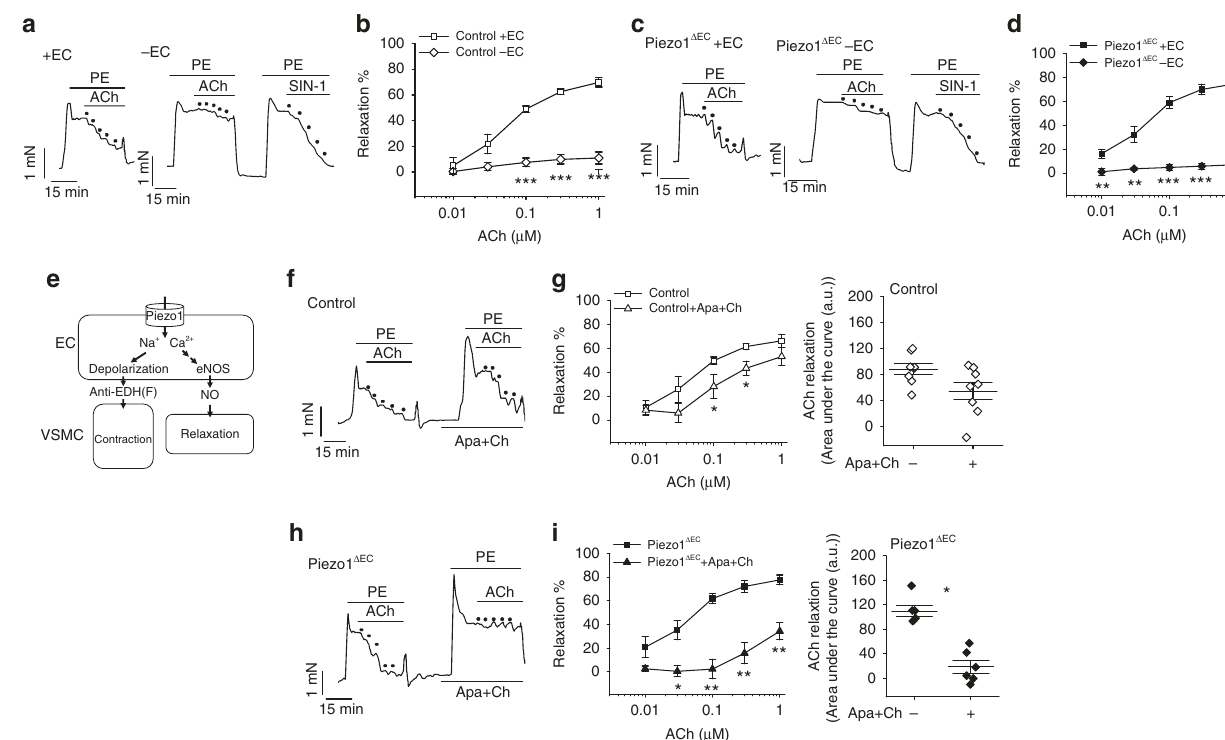
Fig. 2 Endothelial Piezo1 channels have an anti-EDH(F) effect. Isometric tension recordings from mouse second-order mesenteric artery. a Example recordings from control genotype artery before (+ EC) and after endothelium-denudation ( − EC). Upward de fl ection is increasing tension. Phenylephrine (PE, 0.3 μ M). Acetylcholine (ACh) and the nitric oxide donor amino-3-morpholinyl-1,2,3-oxadiazolium (SIN-1) were applied at increasing concentrations as indicated by the dots (0.01, 0.03, 0.1, 0.3 and 1 μ M). b As for a but mean data ( n = 14 mice). c , d As for a , b but Piezo1 Δ EC mice ( n = 10 mice). e Schematic illustration of the dichotomy Piezo1 presents for endothelial biology and vascular function. EC, endothelial cell. VSMC, vascular smooth muscle cell. eNOS, endothelial nitric oxide synthase. NO, nitric oxide. EDH(F), endothelium-derived hyperpolarization (factor). f Example recordings from control genotype artery before and after application of apamin (Apa, 0.5 μ M) and charybdotoxin (Ch, 0.1 μ M). Phenylephrine (PE, 0.3 μ M). Acetylcholine (ACh) was applied at increasing concentrations as indicated by the dots (0.01, 0.03, 0.1, 0.3 and 1 μ M). g As for f but mean data ( n = 8 mice). h , i As for f , g but for Piezo1 Δ EC mice ( n = 6 mice). Averaged data are displayed as mean ± s.e.m. Data sets are compared by t -test. Statistical signi fi cance is indicated by * P < 0.05, ** P < 0.01, *** P <